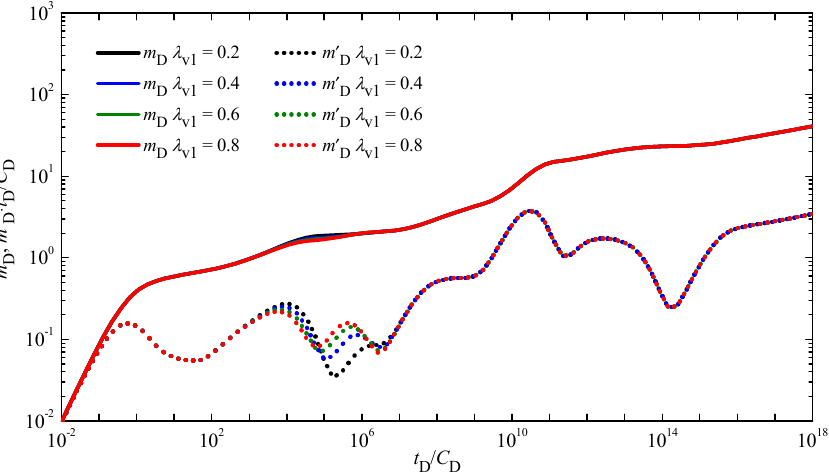
Figure 6. Influence of the inner–zone cave–fracture interporosity flow coefficient on the pressure type curve. type curve.